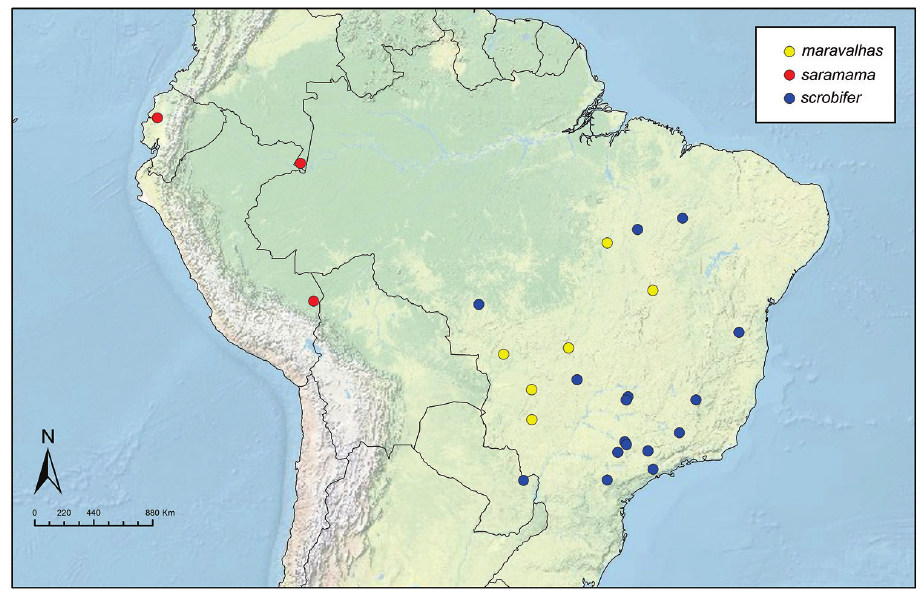
Figure 35. Distribution map of S. maravalhas , S. saramama , and S. scrobifer .